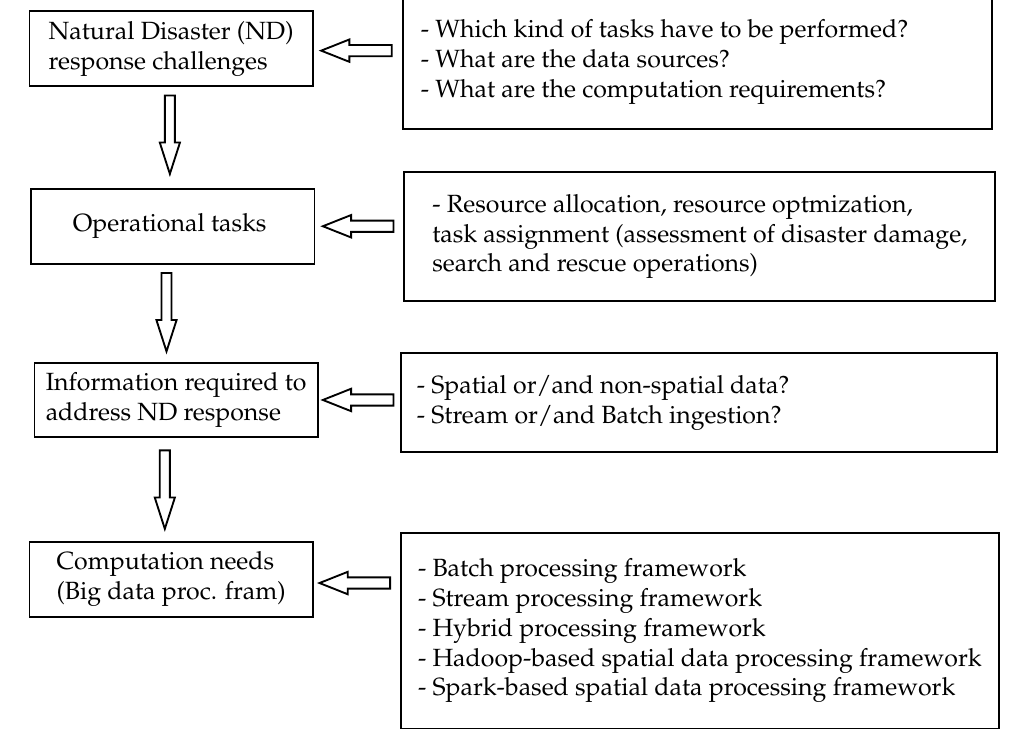
Figure 2. Disaster response questions or